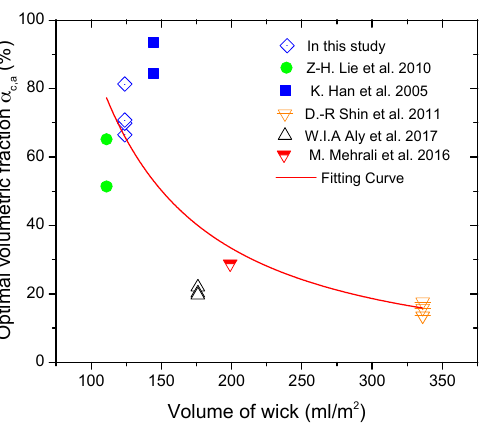
Figure 13. The optimal volumetric fraction of heat pipes from literature as a function of the volume of the wick.